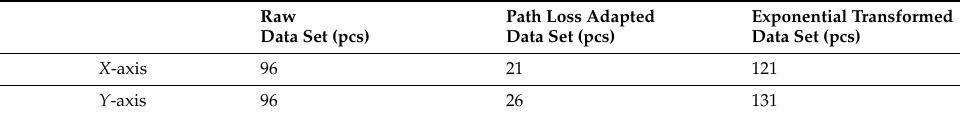
Table 4. Number of parameters in each ANN to be